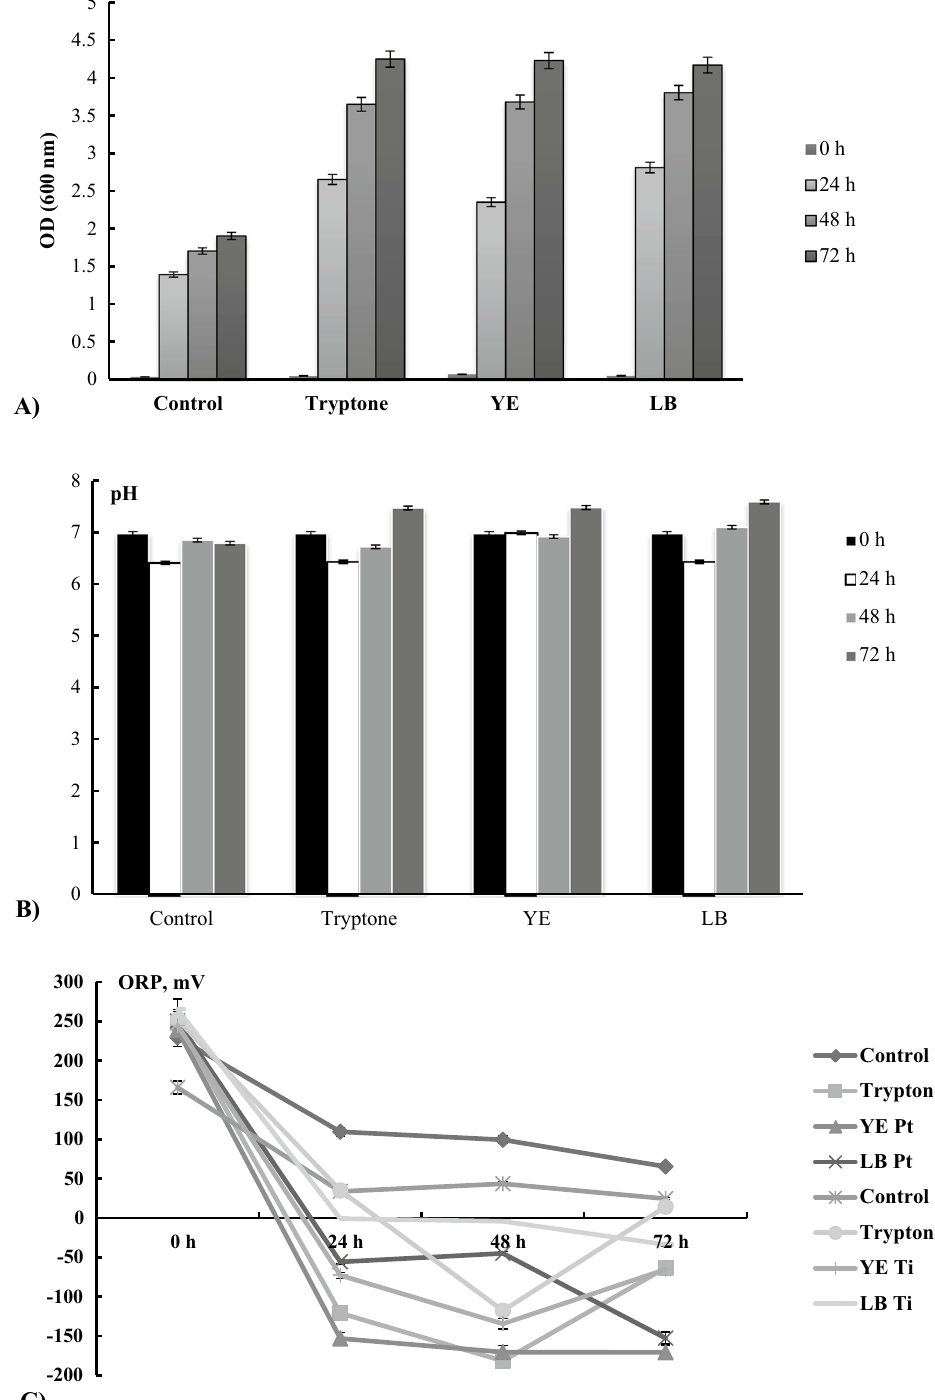
Fig. 1 Effects of LB medium components on R. eutropha H16 bacterial growth parameters. Bacteria were grown aerobically, pH 7.0, for 72 h: Kinetic of A OD (600 nm) (optical density), B pH, and C) ORP, (n 5, p < 0.05). The ORP was measured by using Pt and Ti-Si electrodes and was expressed = in mV [vs Ag/AgCl (saturated by KCl)]. Control is FN (Fructose-Nitrogen medium), 0.5% of LB (Luria–Bertani Medium), and YE- (Yeast extract) and tryptone were supplemented into FN. The average data of 3 independent measurements are presented with standard